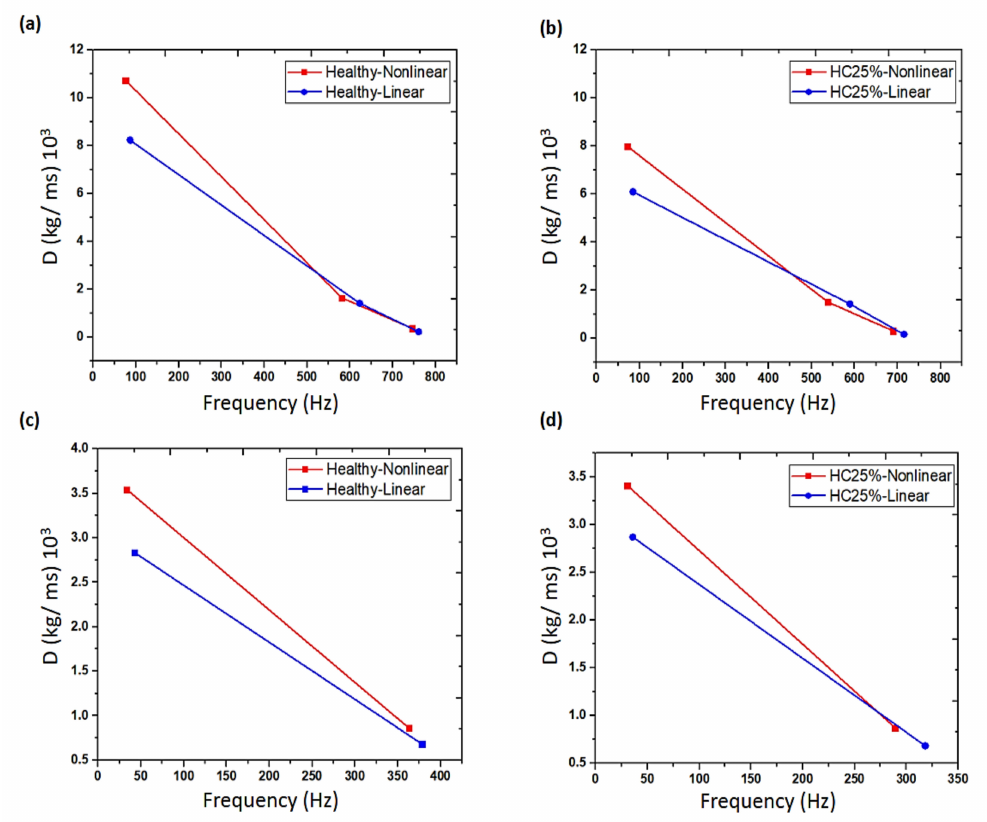
Figure 8. Identified e ff ective damping coe ffi cients for linear and nonlinear areas, for the intact and damaged bonds ( a , b ) with bending modes, ( c , d ) with shear modes [103].